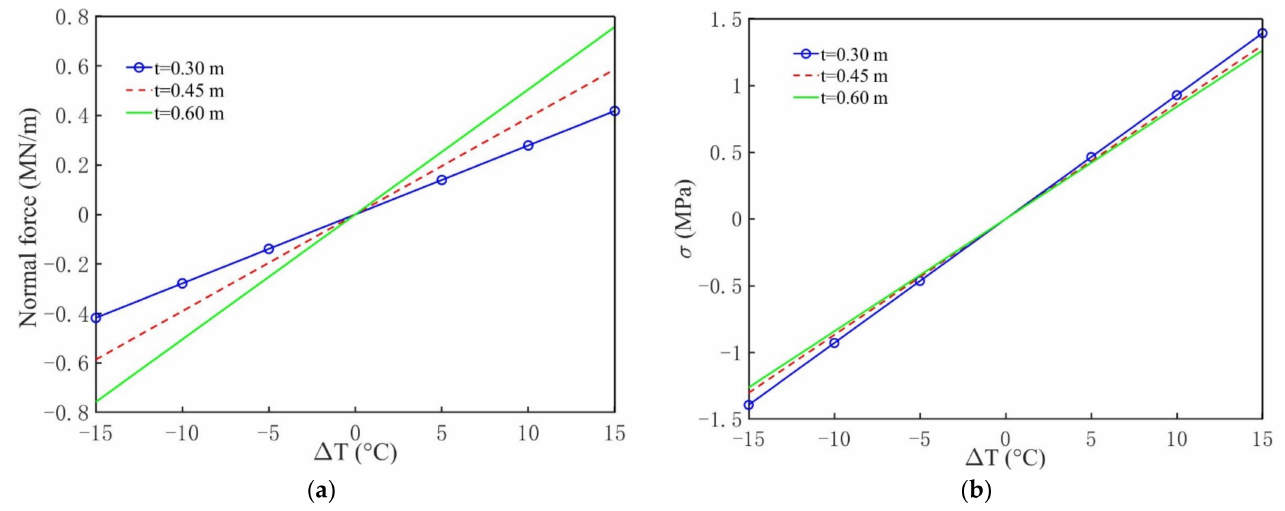
Figure 6. Impact of ∆ T on the internal forces of tunnel lining with different t : ( a ) Normal force; ( b ) Stress of lining σ